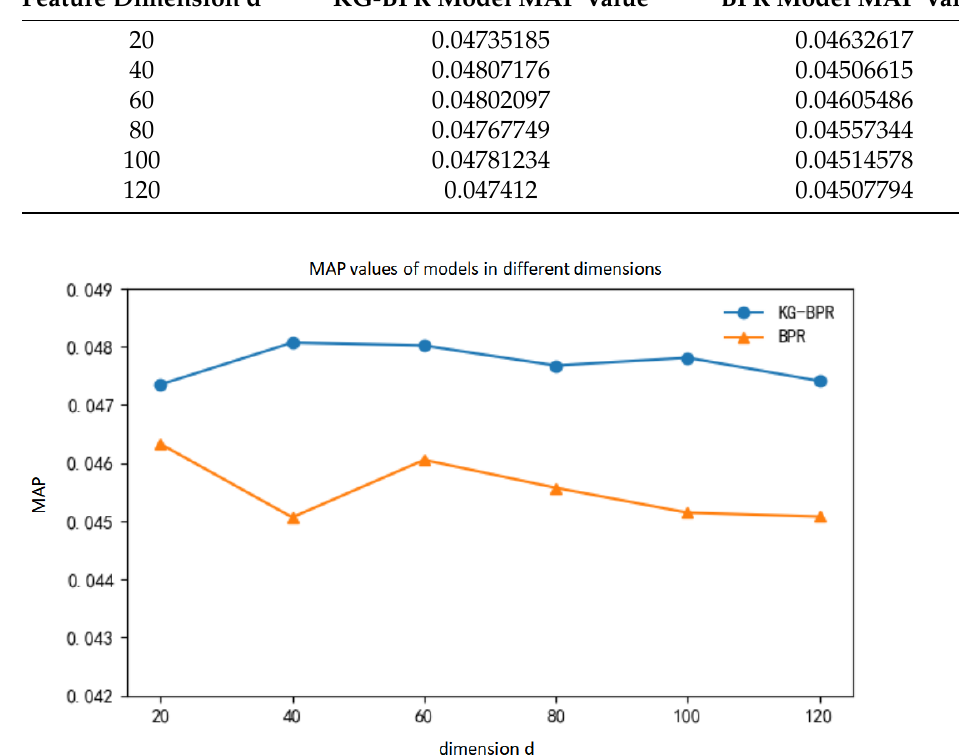
Figure 14. The MAP value of the model in different dimensions.